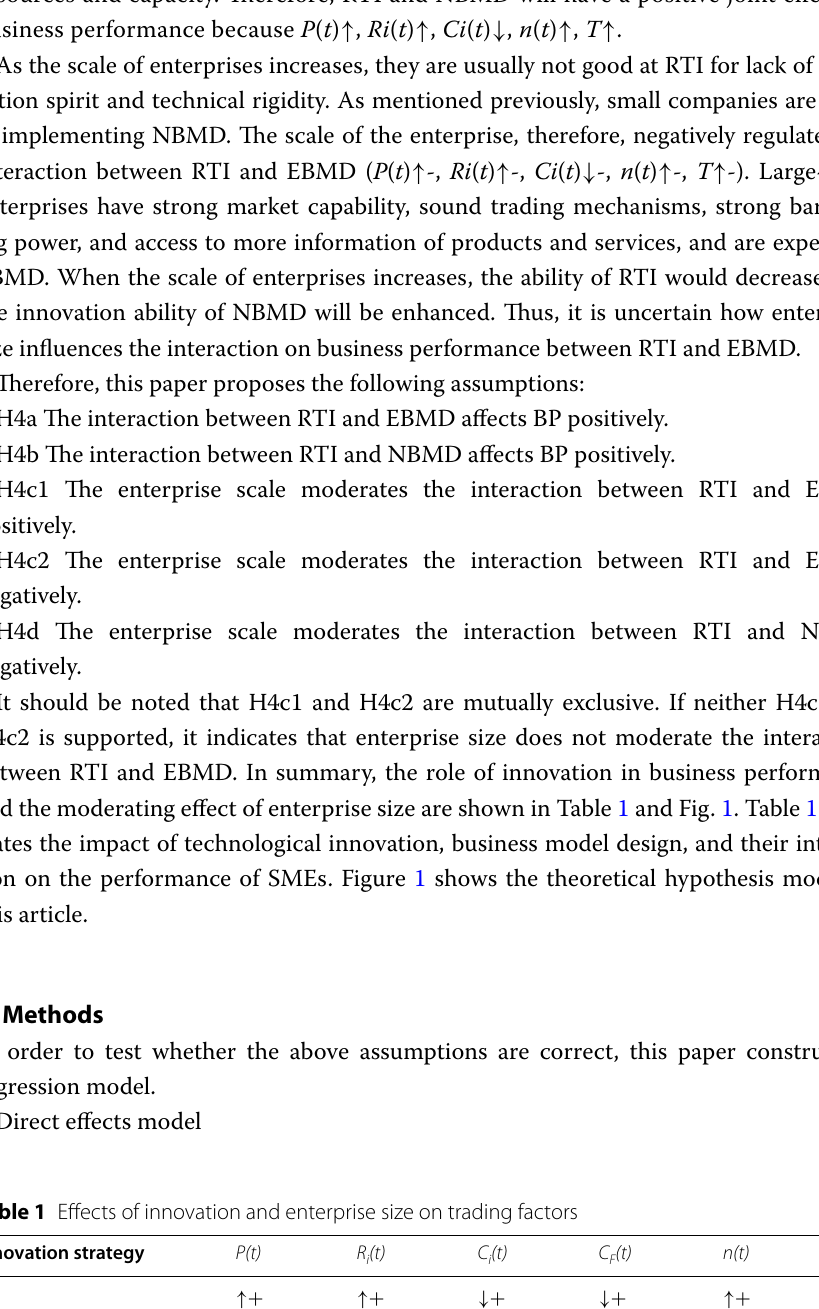
Table 1 Effects of innovation and enterprise size on trading factors Innovation